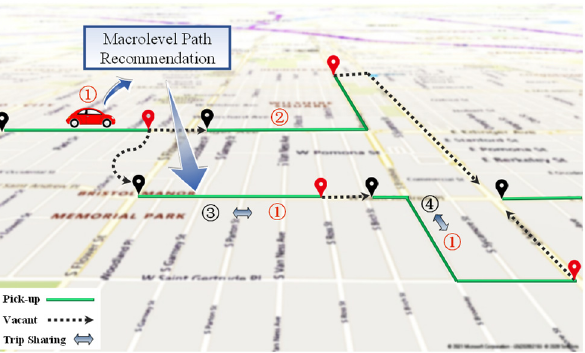
Figure 1. The macro path recommendation scenario. It reduces total operating costs through trip sharing.